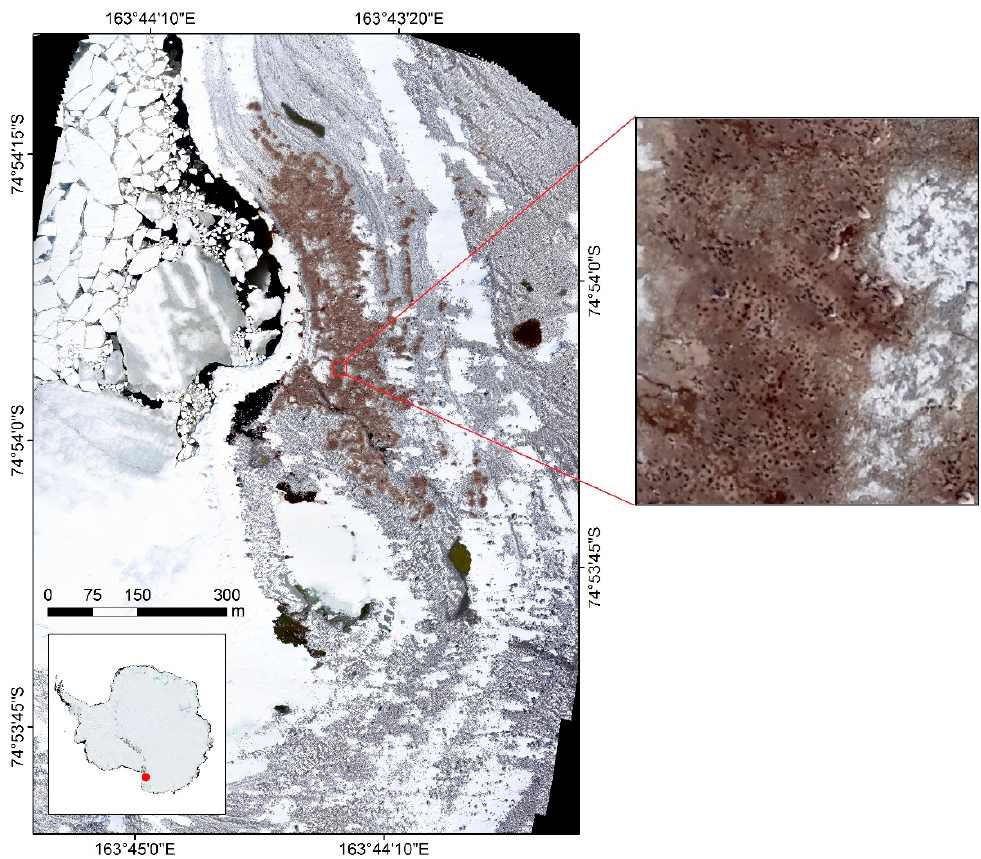
Figure 1. Orthophoto obtained during the UAV surveys on Inexpressible Island in the Ross Sea, Antarctica on 19 January 2018. Brown areas show the penguin colony. Black polygons (right panel) in the colony are penguin shadows.